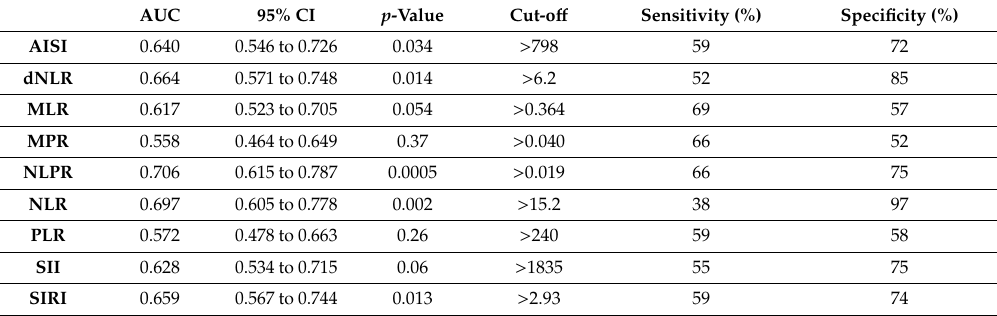
Table 3. Receiver operating characteristics (ROC) curves and prognostic accuracy of blood cell count-derived inflammation indexes.